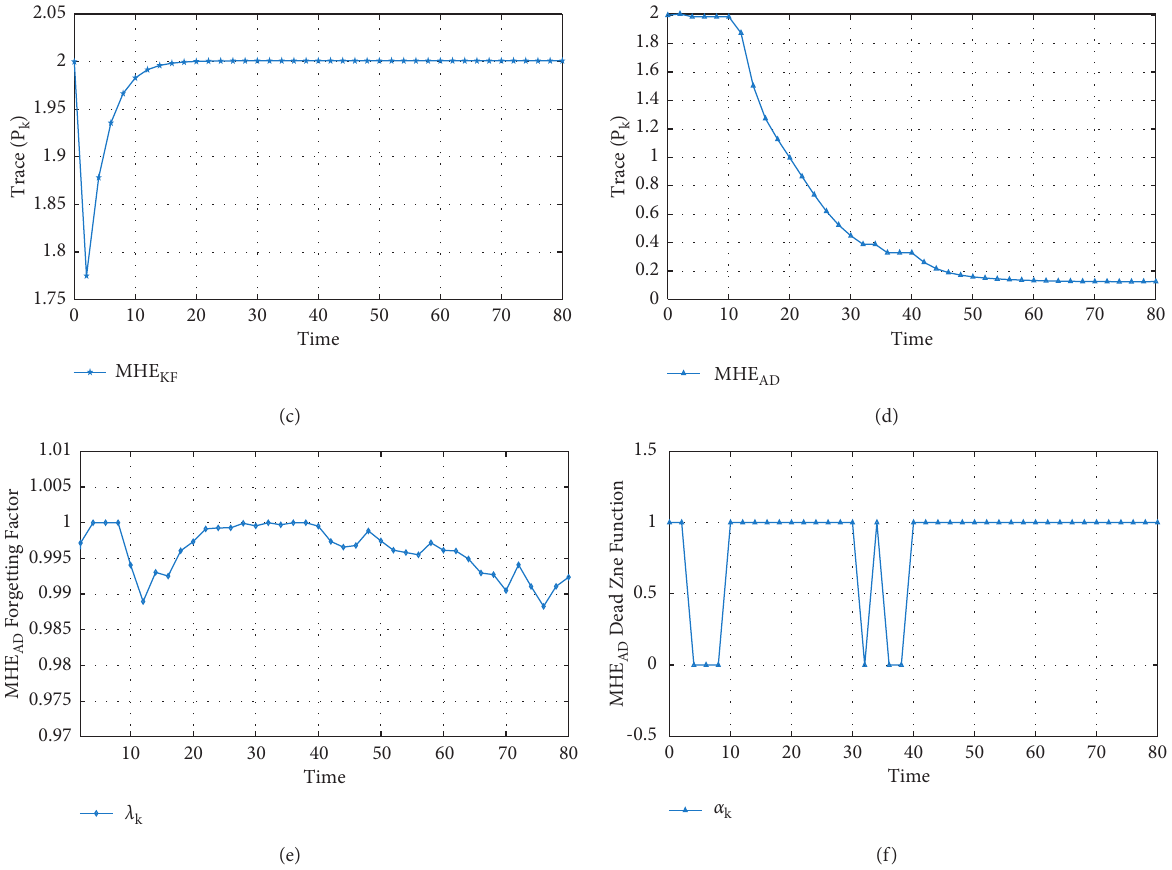
Figure 4: Comparison of estimators for model (16) with horizon length N � 10 and variable σ ) − MHE ) − MHE x ( 2 ) . (c) Trace ( P . (d) Trace ( P . (e) Forgetting factor. (f) Dead zone function. ℓ KF ℓ AD